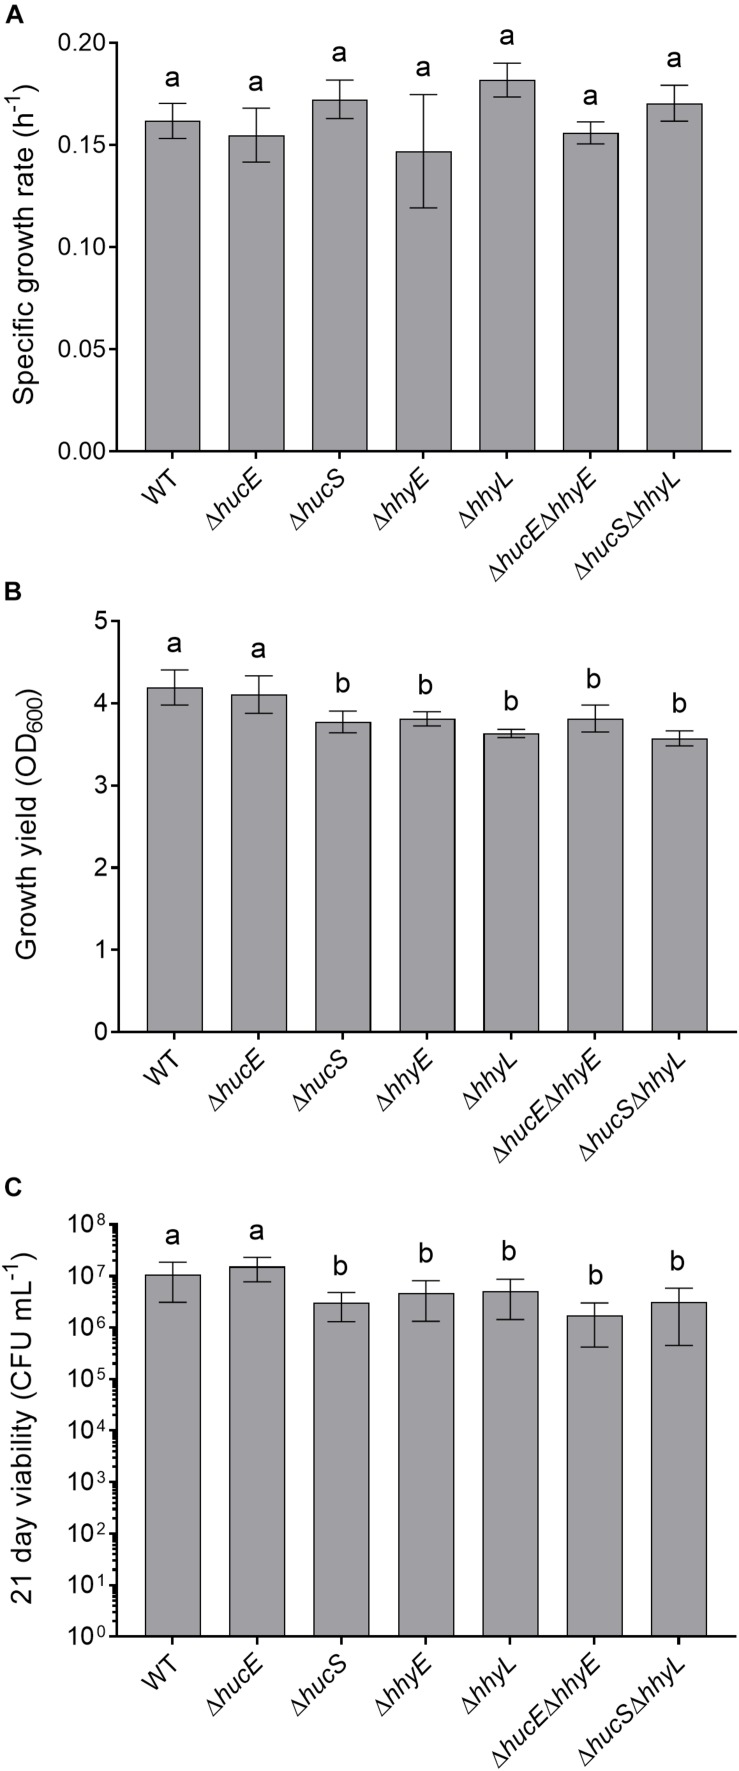
Comparison of growth and survival between wild-type and mutant strains of M. smegmatis. Seven strains were grown on lysogeny broth supplemented with Tween80 (LBT): wild-type, single and double mutants of the iron-sulfur proteins (ΔhucE, ΔhhyE, ΔhucEΔhhyE), and single and double mutants of hydrogenase structural subunits (ΔhucS, ΔhhyL, ΔhucSΔhhyL). (A) Specific growth rate (μ) during exponential phase. (B) Final growth yield (ODmax) at 24 h post-stationary phase. (C) Long-term survival (CFU mL– 1) at 21 days post-stationary phase. Error bars show standard deviations of six biological replicates. Values labeled with different letters are significantly different (p < 0.05) based on a one-way ANOVA.